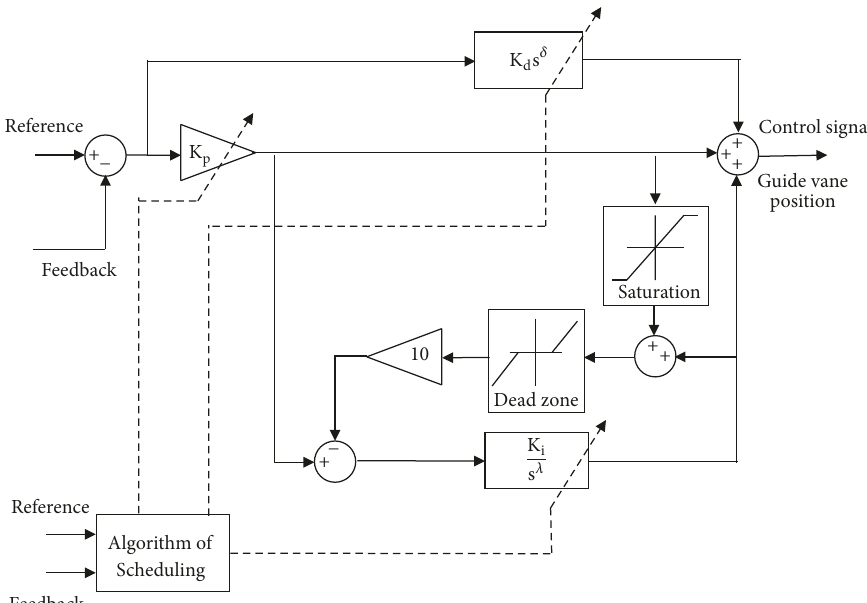
Figure 6: General structure of the antiwindup PI 𝜆 D 𝛿 gain scheduling controller.